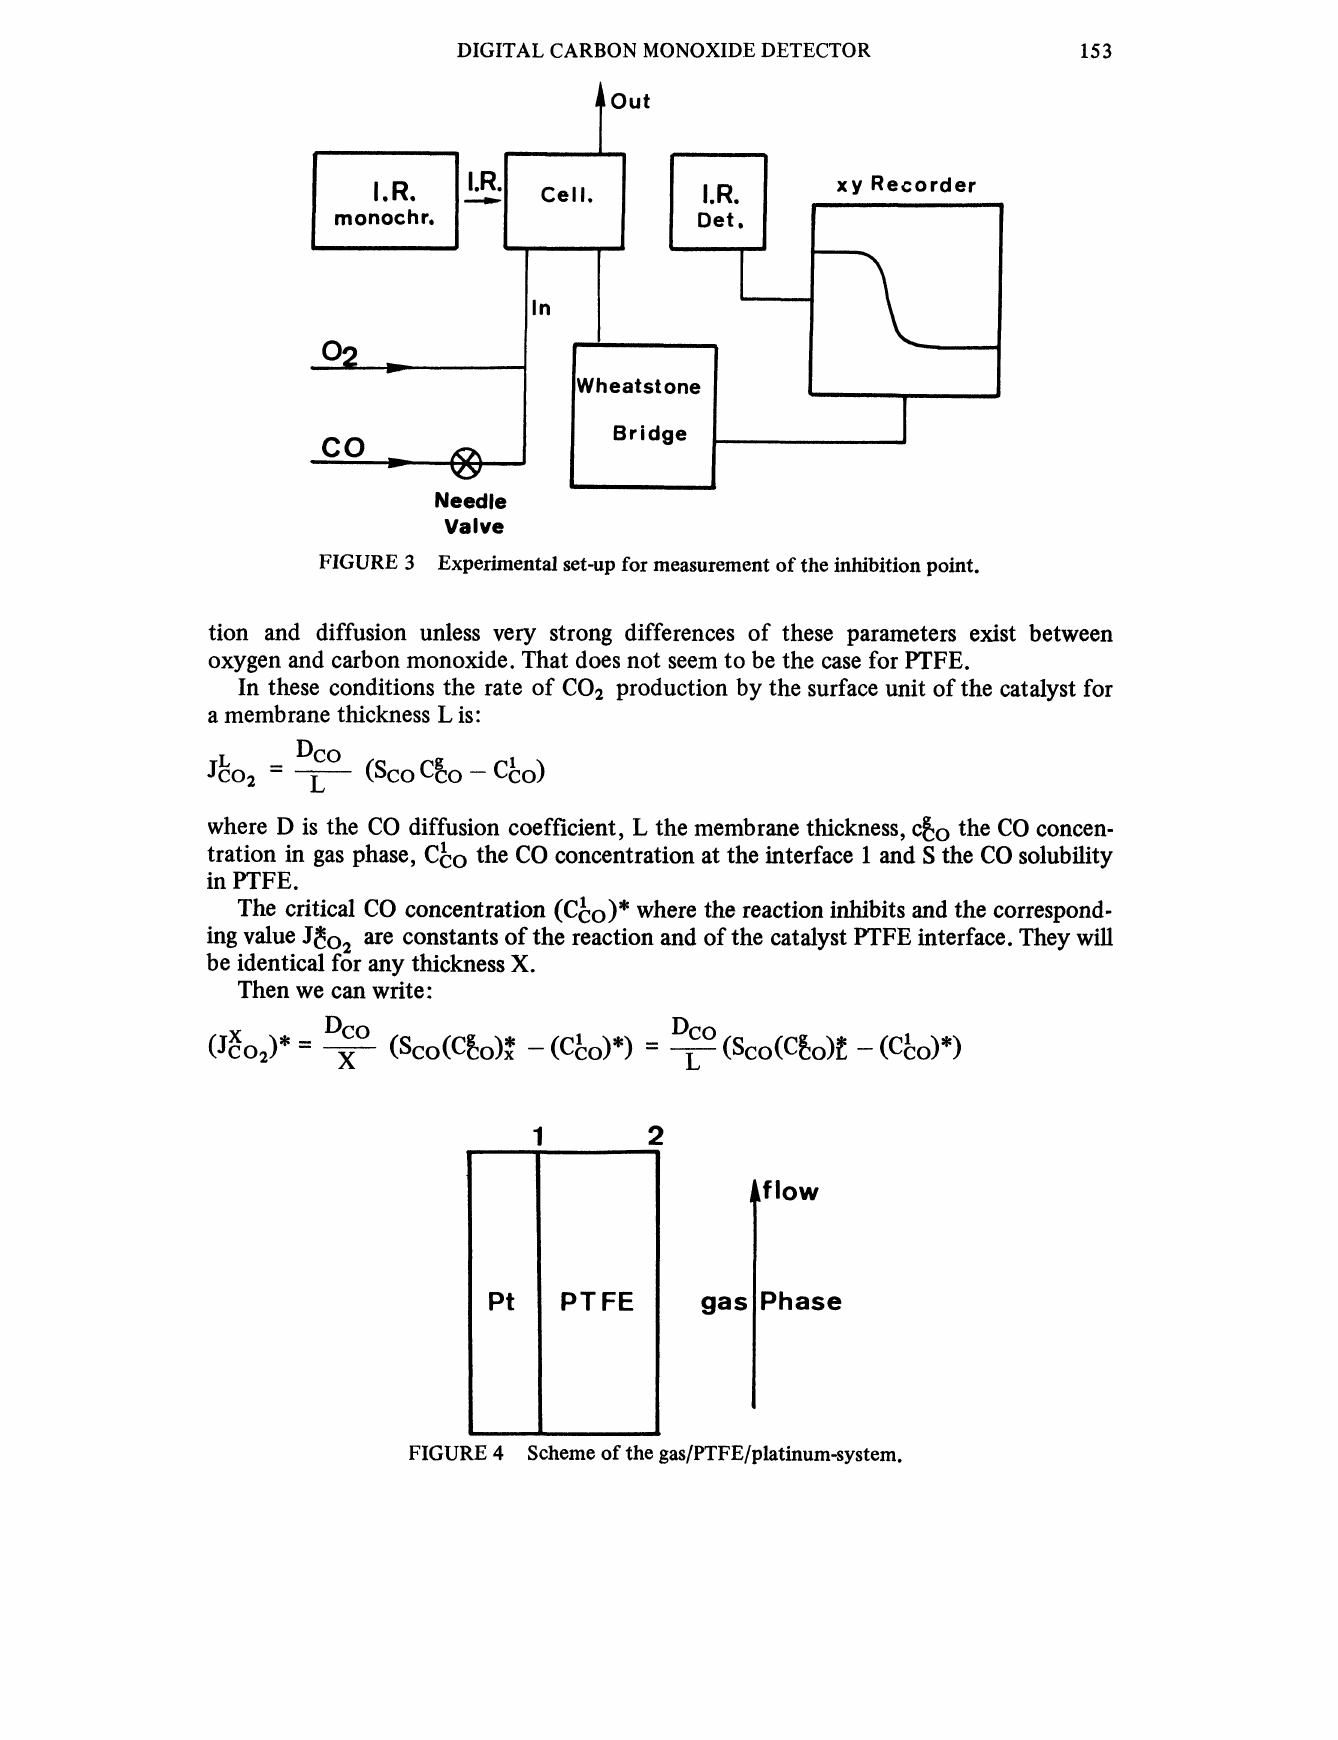
FIGURE 4 Scheme of the